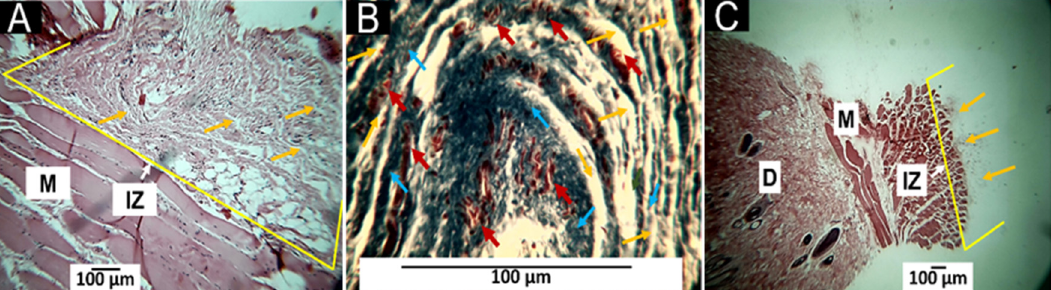
Figure 7. Subdermal implant formulation T1, 100%CS. ( A ): Implantation at 30 days, the image at 10×, Hematoxylin and Eosin (H&E) staining. ( B ): Implantation at 30 days, the image at 100×, Masson Trichrome (MT) staining. ( C ): Implantation at 60 days, 4× image, H&E technique. M: muscle. IZ: implantation zone. Yellow arrow: fragments of the biomaterial. Blue arrows: connective tissue (type I collagen). Red arrows: blood vessels. D: dermis.